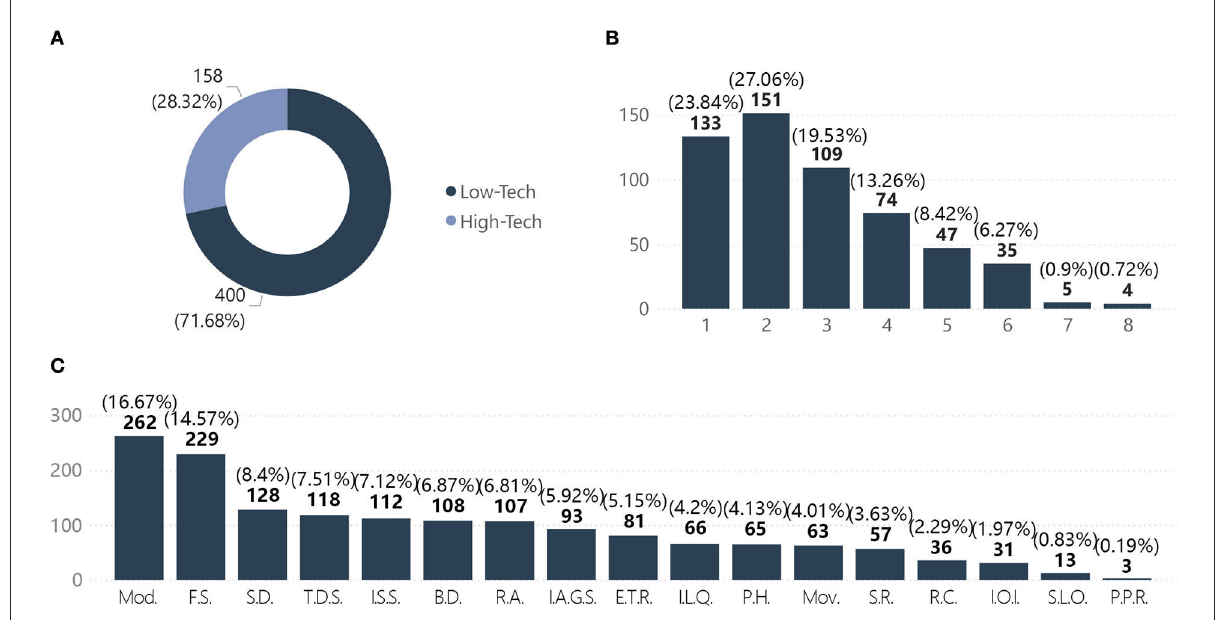
FIGURE6 Distribution of strategies. (A) Technical orientation. (B) Quantities of strategies. (C) Strategies